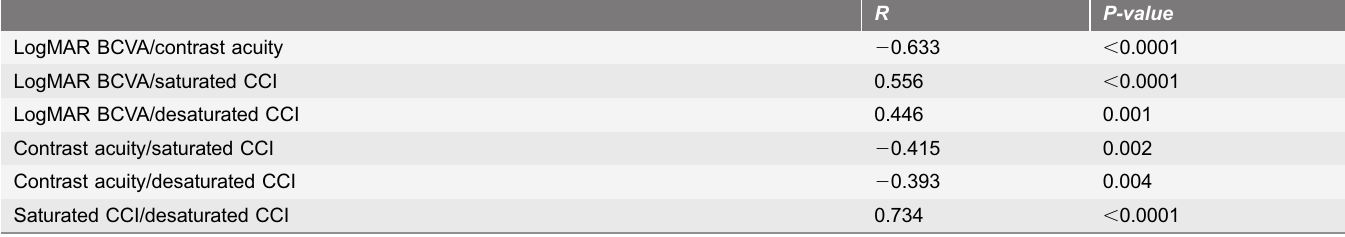
Table 3. Spearman’s rank correlation coefficients between LogMAR BCVA, log contrast acuity, and CCI (saturated and